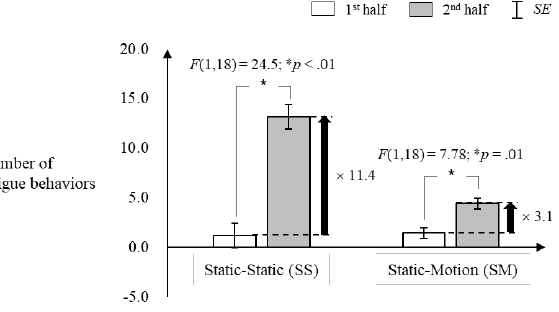
Figure 6. Number of fatigue behaviors.